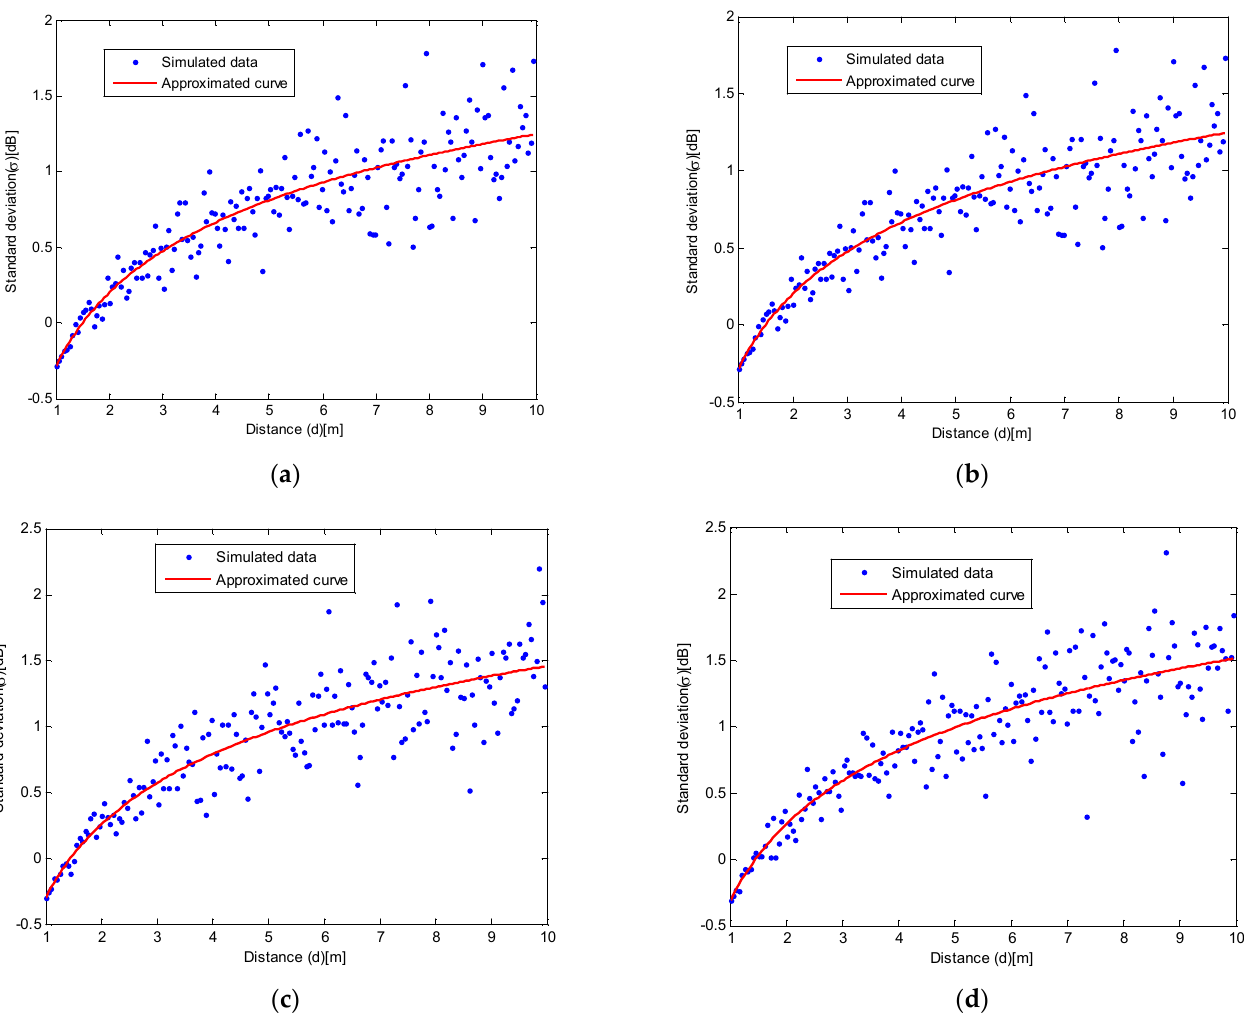
Figure 7. ( a ) Relationship of the noise standard deviation and distance based on simulated data for case 1; ( b ) Relationship of the noise standard deviation and distance based on simulated data for case 2; ( c ) Relationship of the noise standard deviation and distance based on simulated data for case 3; ( d ) Relationship of the noise standard deviation and distance based on simulated data for case 4.